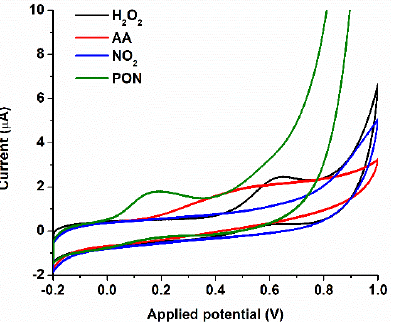
Figure 6. Evaluation of the interfering species using CV for 100 µM peroxynitrite (PON—green): 100 µM ascorbic acid (AA—red), 100 µM hydrogen peroxide (H 2 O 2 —black), 100 µM nitrite (NO 2 — blue), using a glassy carbon electrode (GCE)/CoPc electrode. Scan rate 100 mV/s, electrolyte: PBS pH 9 0.1M + 0.1 M KCl [1] .